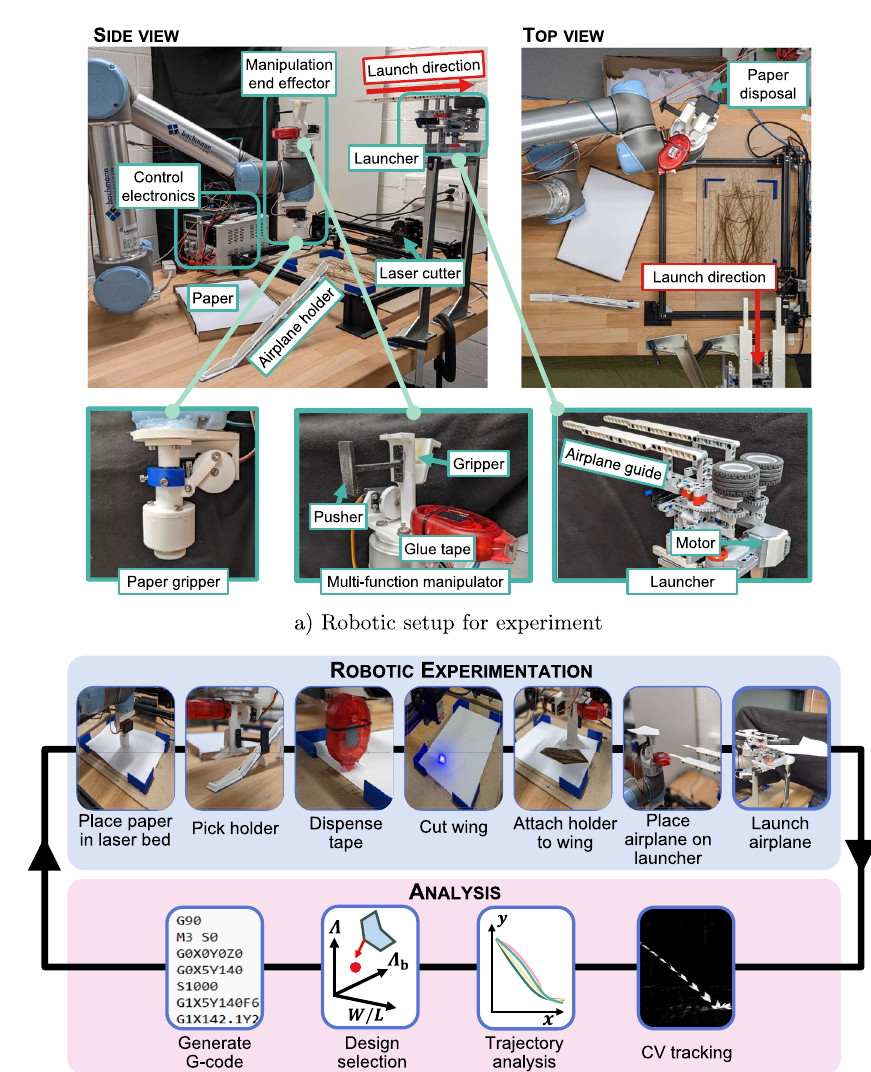
Figure 5. ( a ) Robotic experimental setup for paper airplane fabrication and launching. ( b ) Iterative process followed by the robot designer alternating between experimentation and analysis in a